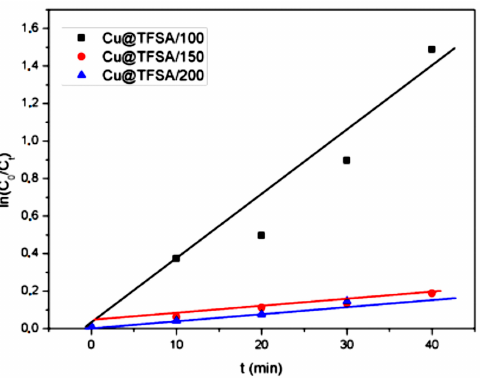
Figure 8. The plot of ln(C 0 /C t ) vs. time, t, varying the copper loading on the